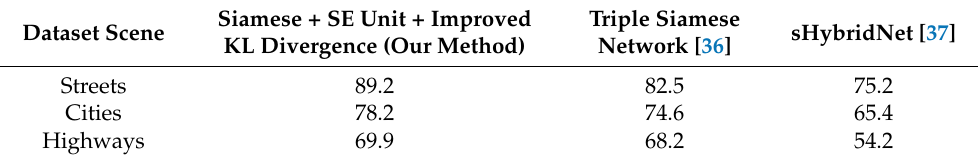
Table 4. Comparison of different approach.